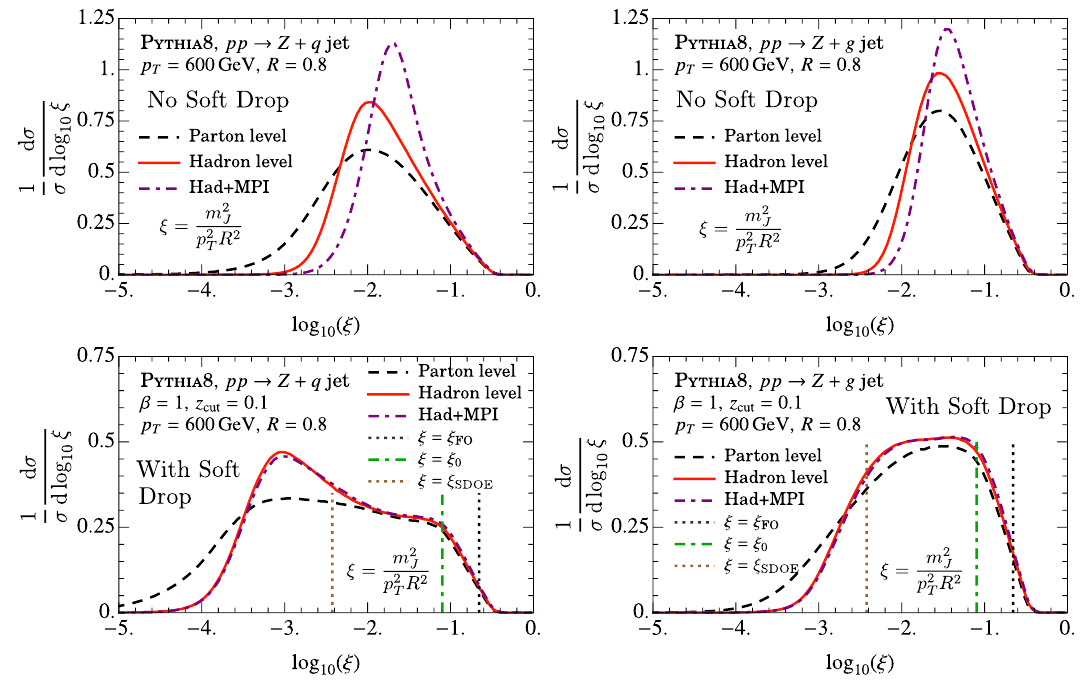
Figure 1 . Jet-mass spectrum for quark and gluon jets in Pythia8 , at parton and hadron levels and with the underlying event (modeled as multi-parton-interaction (MPI)) with and without soft-drop grooming. We use the shorthand ξ = m 2 / ( p T R ) 2 . The green vertical dot-dashed line indicates J the jet masses below which soft-drop grooming becomes active and the groomed spectrum deviates significantly from the corresponding ungroomed spectrum. To the right of the black-dotted line, for ξ & ξ ,the fixed order non-singular corrections to the spectrum become important. For the FO soft-drop spectrum, the nonperturbative corrections become O (1) only to the left of the brown dotted line given by ξ = ξ SDOE